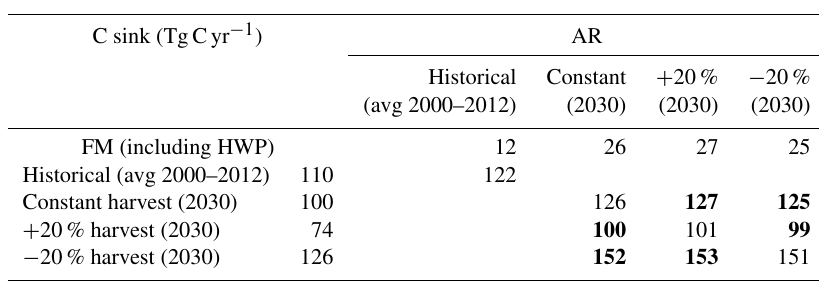
Table 4. Total C sink estimated by our study for the historical period (average 2000–2012) and for 2030 resulting from combining (i) different harvest scenarios (constant, + 20 and − 20% in 2030, compared with the historical period) applied to the FM area with (ii) different AR scenarios (constant, + 20 and − 20% in 2030, compared with the historical period). Bold values highlight other possible scenarios not directly considered by our study. FM: forest management area, i.e., area of the existing forests in 1990. AR: afforestation and reforestation that has occurred since 1990. HWP: harvested wood